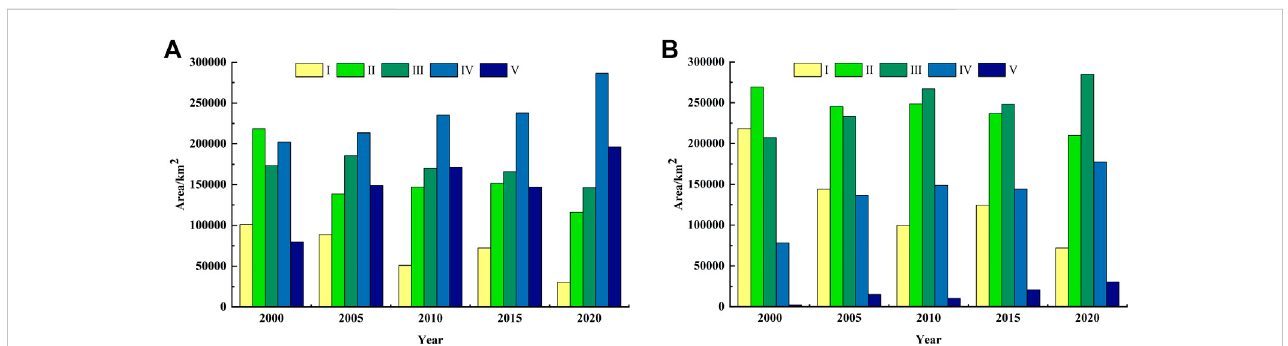
FIGURE 3 The (A) annual and (B) growing season NDVI values and areas of regions within each class. I: low vegetation coverage (0.0 < NDVI ≤ 0.2), II: medium-low vegetation coverage (0.2 < NDVI ≤ .4), III: medium vegetation coverage (0.4 < NDVI ≤ 0.6), IV: medium-high vegetation coverage (0.6 < NDVI ≤ 0.8), V: high vegetation coverage (0.8 < NDVI ≤